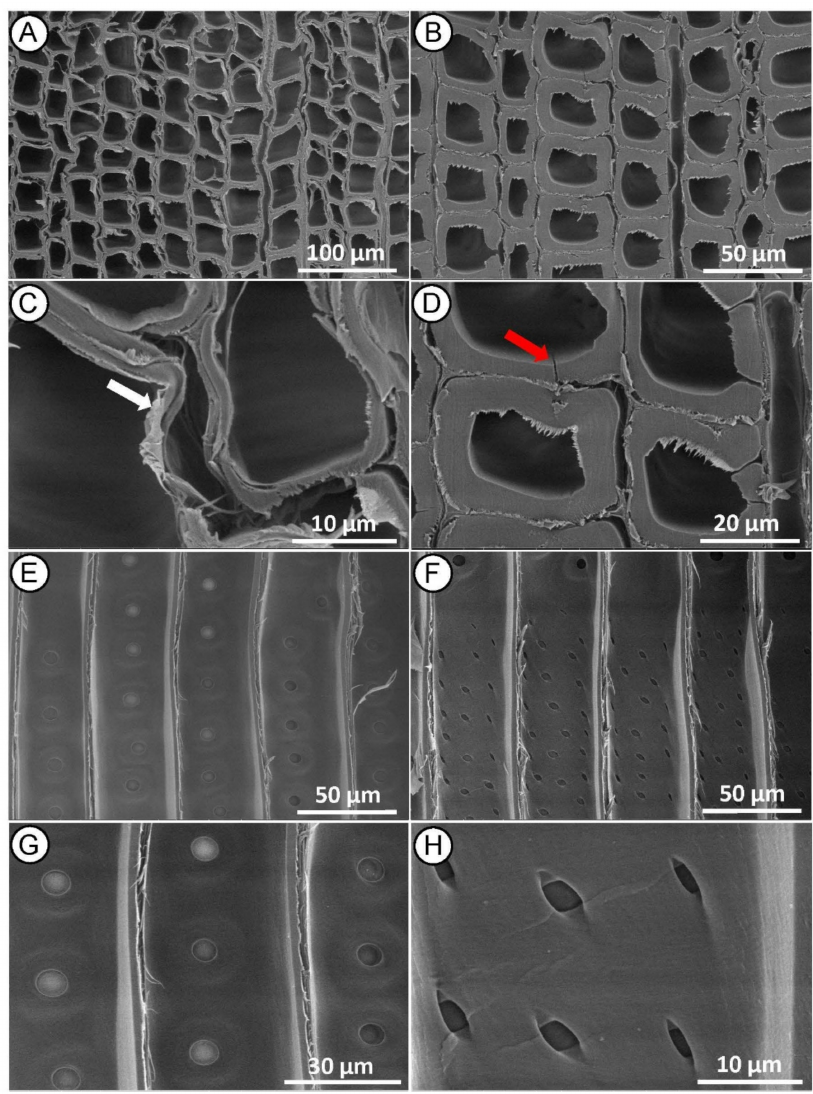
Figure 4. SEM micrographs of Norway spruce heartwood after MI MW treatment. Cross-section showing collapsed tracheids in earlywood (( A , C )—white arrow) and cracked tracheids in latewood (( B , D )—red arrow). Radial-section with mostly aspirated bordered pits on the tracheid walls ( E , G ) and mainly undamaged piceoid cross-field pits ( F , H